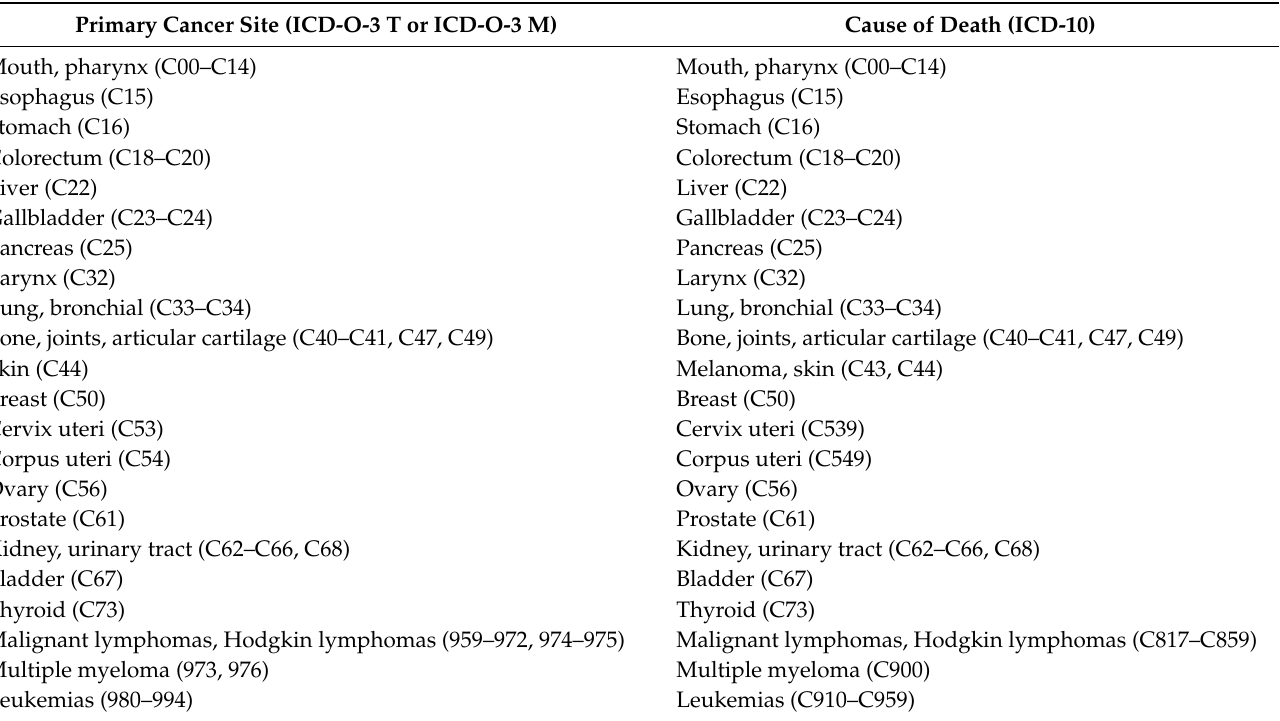
Table 1. Correspondence between ICD-O-3 T and ICD-O-3 M codes on cancer incidence, and IDC-10 code on the cause of